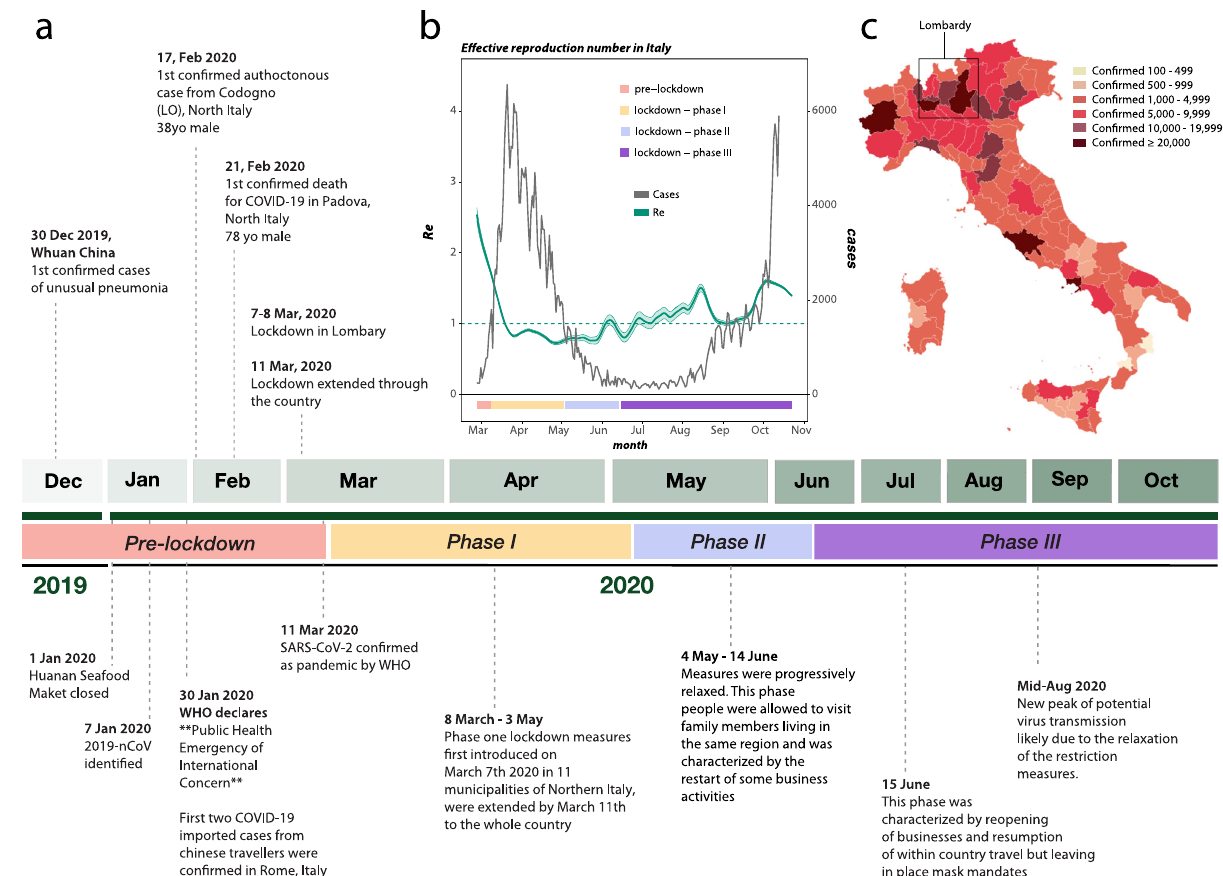
Fig. 1 History of SARS-CoV-2 epidemic in Italy. a Timeline of key events following the fi rst con fi rmed cases of SARS-CoV-2 infection in Italy. b Epidemic curve showing the progression of reported daily viral infection numbers in Italy from the beginning of the epidemic in March (black) and changes in Re estimations in the same period (green), with lockdown phases indicated along the bottom. c Map of cumulative SARS-CoV-2 cases per 100,000 inhabitants in Italy up to Oct